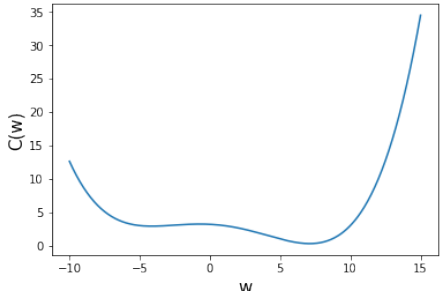
Figure 2. Cost function with one local